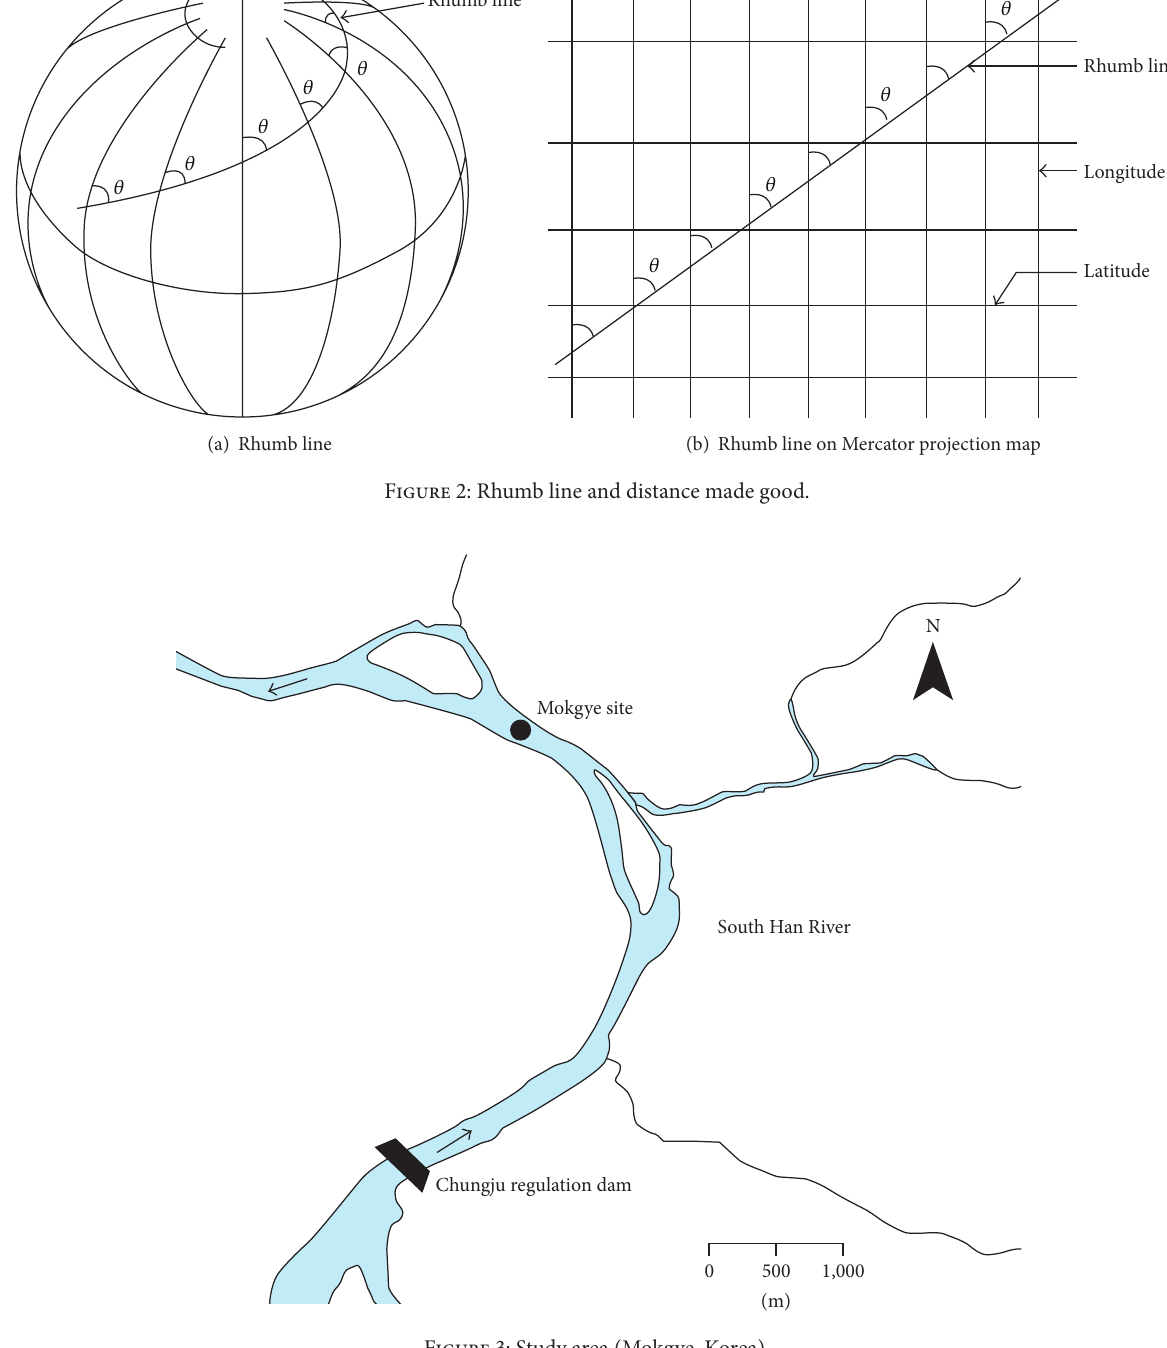
Figure 3: Study area (Mokgye,